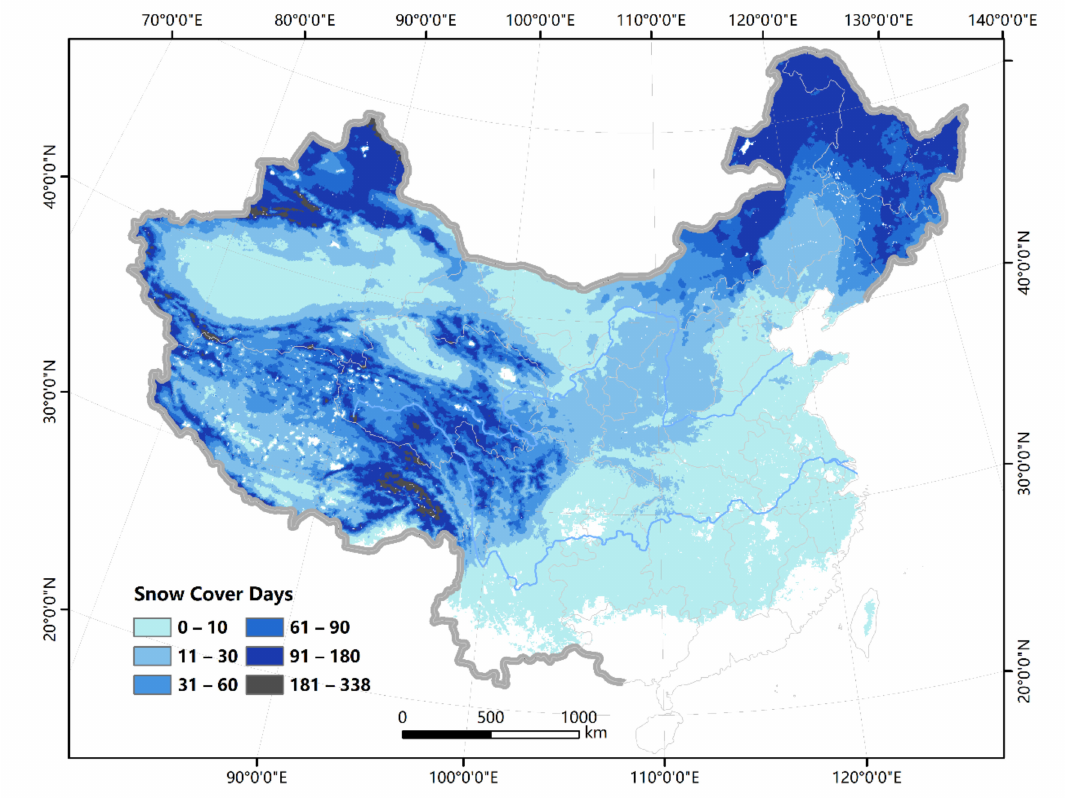
Figure 7. Distributions of the long-term mean annual ASCDs across China during 1981–2019. Avalanches mostly occur in mountainous areas (the Altai Mountains, the Tianshan Mountains, the eastern and southeastern mountainous areas in the Tibetan Plateau) with complex terrain [38]. There is a thicker depth hoar and more water content in the snow profile, especially in spring, leading to the destruction of snow cover stability. Blowing snow is affected by climatic factors, topography, and geographical location. It occurs occasionally in the high-mountain areas of northwest and southwest China, the Inner Mongolia Plateau, and the Songliao Plain of northeast China. Avalanches and blowing snow are usually observed in persistent and periodic variable snow cover areas. Although these two types of snow disasters are more harmful, special monitoring and forecasting have been carried out based on the relatively fixed occurrence time of snowfall and snow cover